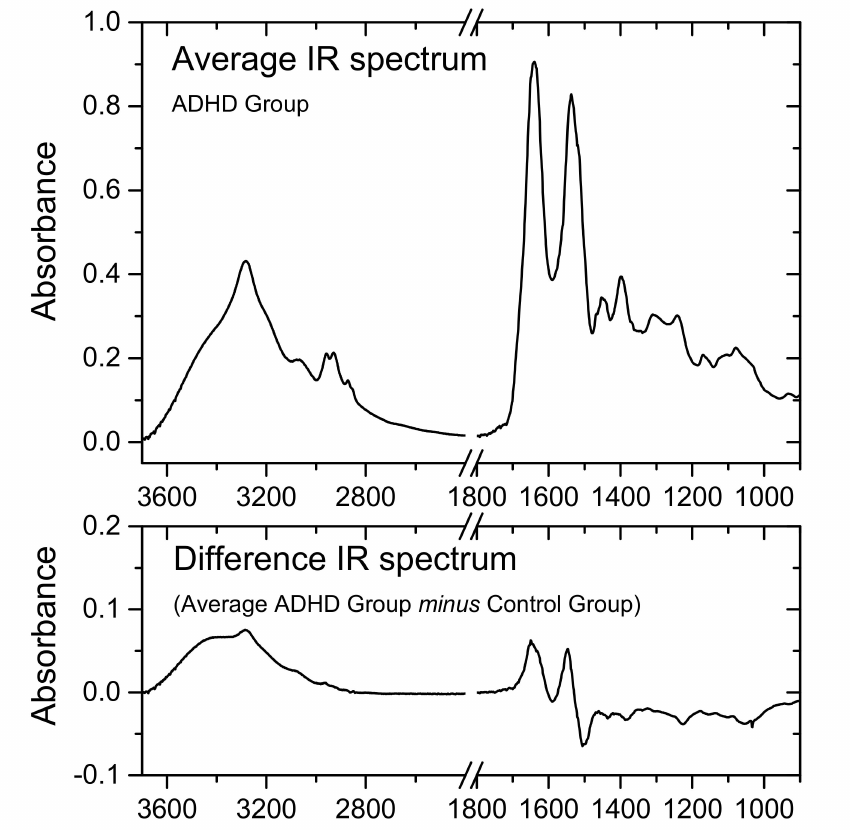
Figure 2. Average IR spectrum of ADHD group blood serum samples (3700–2400 and 1800–900 cm − 1 regions; top panel), and difference spectrum obtained by subtracting the average spectrum of the Control group to the average spectrum of the ADHD group (bottom). The average IR spectrum of the Control group is provided in Figure S1 (Supplementary